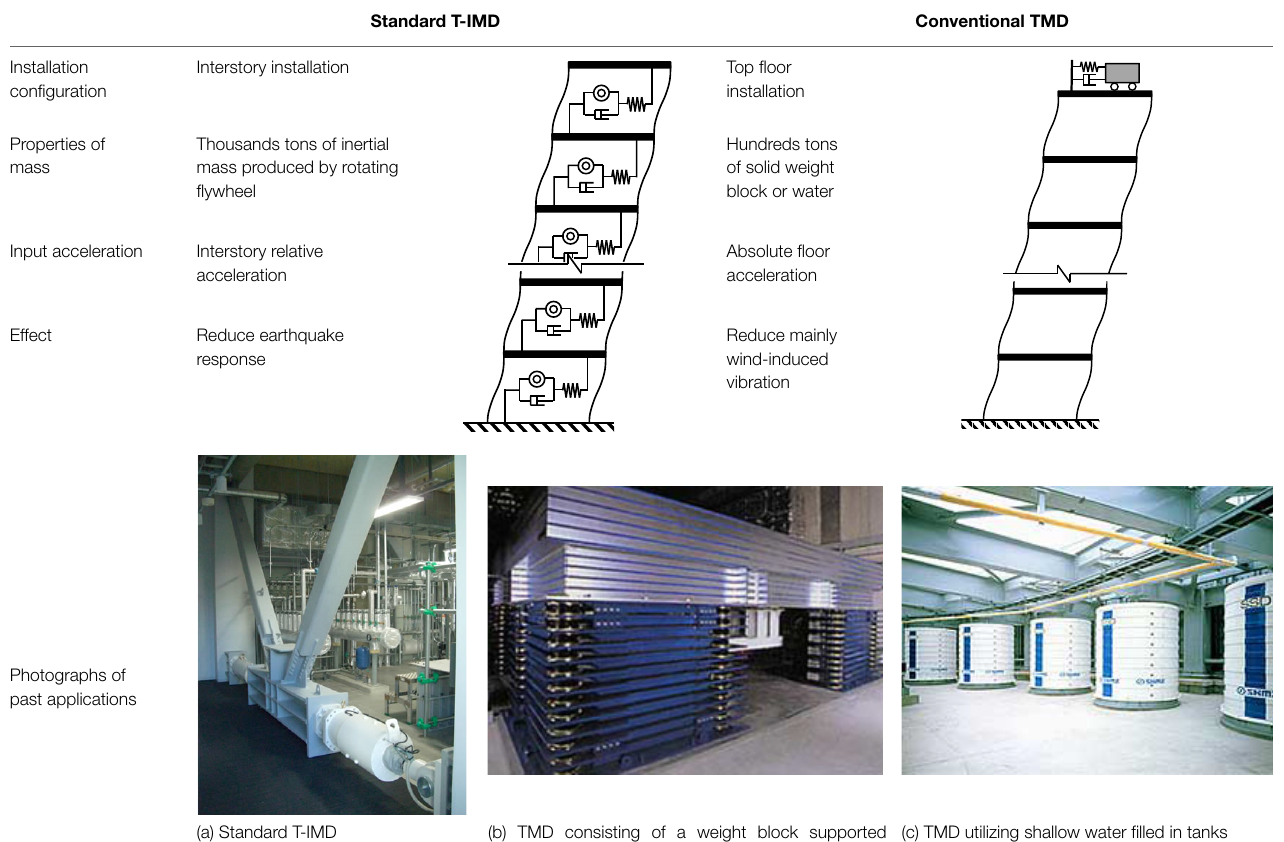
TABLE 2 | Comparison between the standard tuned inertial mass damper (T-IMD) and the conventional tuned mass damper (TMD)